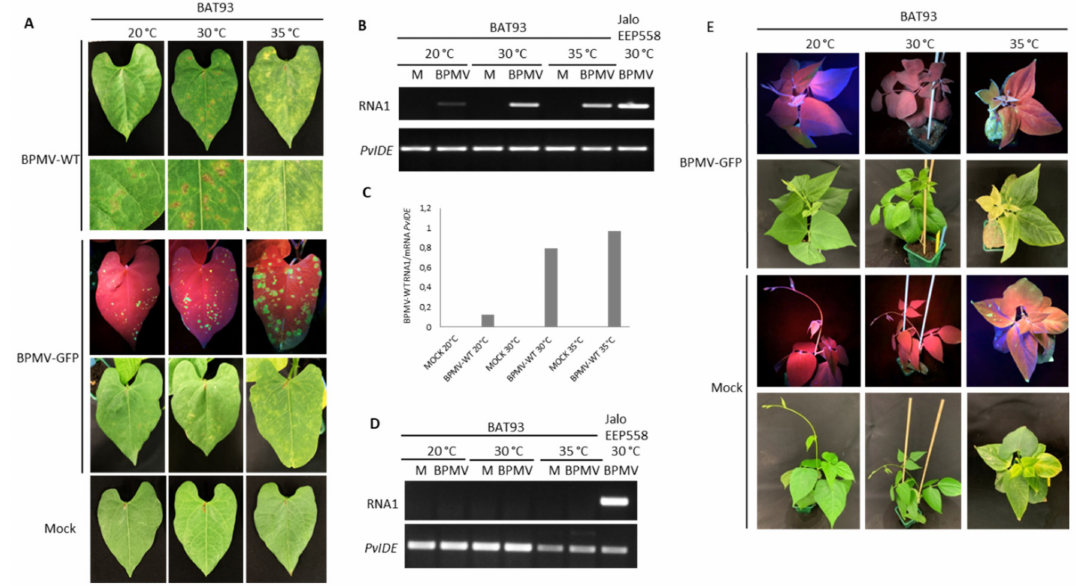
Figure 3. The R-BPMV gene of BAT93 is still efficient to confer BPMV resistance at 35 ◦ C: ( A ) Representative pictures of BAT93-inoculated leaves at 20 ◦ C, 30 ◦ C and 35 ◦ C, 7 days post-inoculation (dpi) with BPMV-WT (upper panel; six plants), BPMV-GFP (middle panel; six plants) and Mock (lower panel; six plants). BPMV-GFP was detected under UV light. This experiment was performed at least three times with similar results. ( B ) Semi-quantitative RT-PCR of BPMV RNA1 (upper panel) in BAT93-inoculated leaves. Plants were inoculated with either mock (M) buffer or BPMV-WT (BPMV) at 20 ◦ C, 30 ◦ C and 35 ◦ C. PvIde was used as an internal control. Total RNA was extracted at 7 dpi from a pool of three BAT93-inoculated leaves sampled on three different plants. A sample of inoculated leaves of JaloEEP558 at 30 ◦ C was taken as positive control for PCR amplification. ( C ) Quantification of BPMV titer at 7 dpi in BPMV-WT-inoculated leaves of BAT93 by calculation of the relative ratio of BPMV RNA1 to plant mRNA of PvIde using a quantitative RT-PCR procedure. Data are mean ratios of pools of three BAT93-inoculated leaves sampled on three different plants. ( D ) Semi-quantitative RT-PCR of BPMV RNA1 (upper panel) in systemic leaves of BAT93 plants inoculated with either mock (M) buffer or BPMV-WT (BPMV) at 20 ◦ C, 30 ◦ C and 35 ◦ C. PvIde was used as an internal control. Total RNA was extracted at 14 dpi from a pool of two systemic leaves (third and fourth trifoliate) sampled on two-three different plants of BAT93. A sample of inoculated leaves of JaloEEP558+BPMV-WT at 30 ◦ C was taken as positive control for PCR amplification. This experiment was performed twice with similar results. ( E ) Representative pictures of six whole plants of BAT93 at 20 ◦ C, 30 ◦ C and 35 ◦ C, 11 dpi with either BPMV-GFP (upper panel) or mock buffer (lower panel). BPMV-GFP was detected under UV